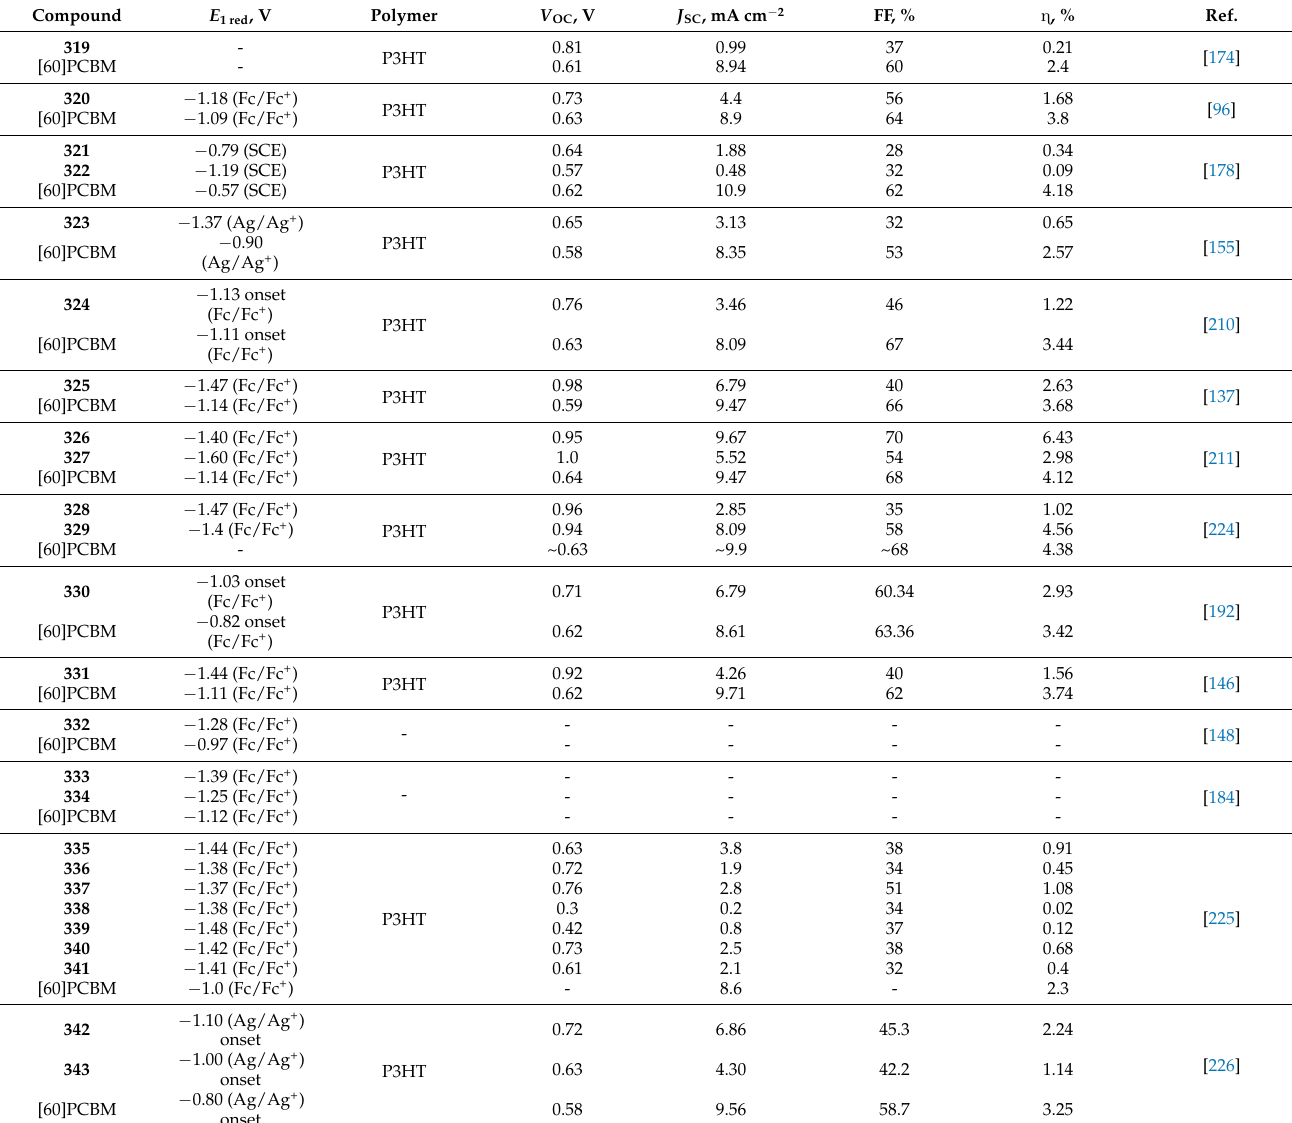
Table 11. First reduction potentials and characteristics of the solar cells based on the polyadducts with reduced electron